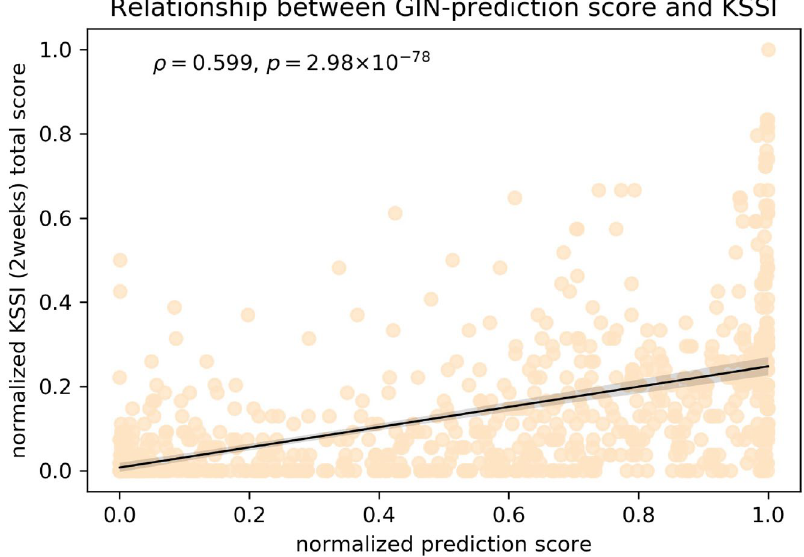
Figure 4. Scatter plot showing the normalized raw prediction score of the model and KSSI total score ( n = 792 of 13,408; the part of the test set with KSSI scores). Spearman’s correlation coefficient between the prediction score of the model and the KSSI total score was ρ pred = 0.599 ( p <